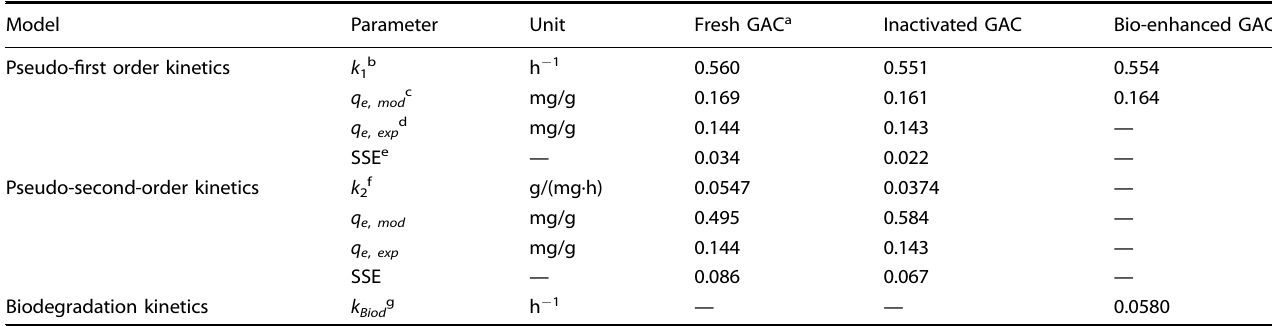
Table 2. Parameters of the adsorption and biodegradation kinetics during batch-mode LAS removal in various GAC-based systems.